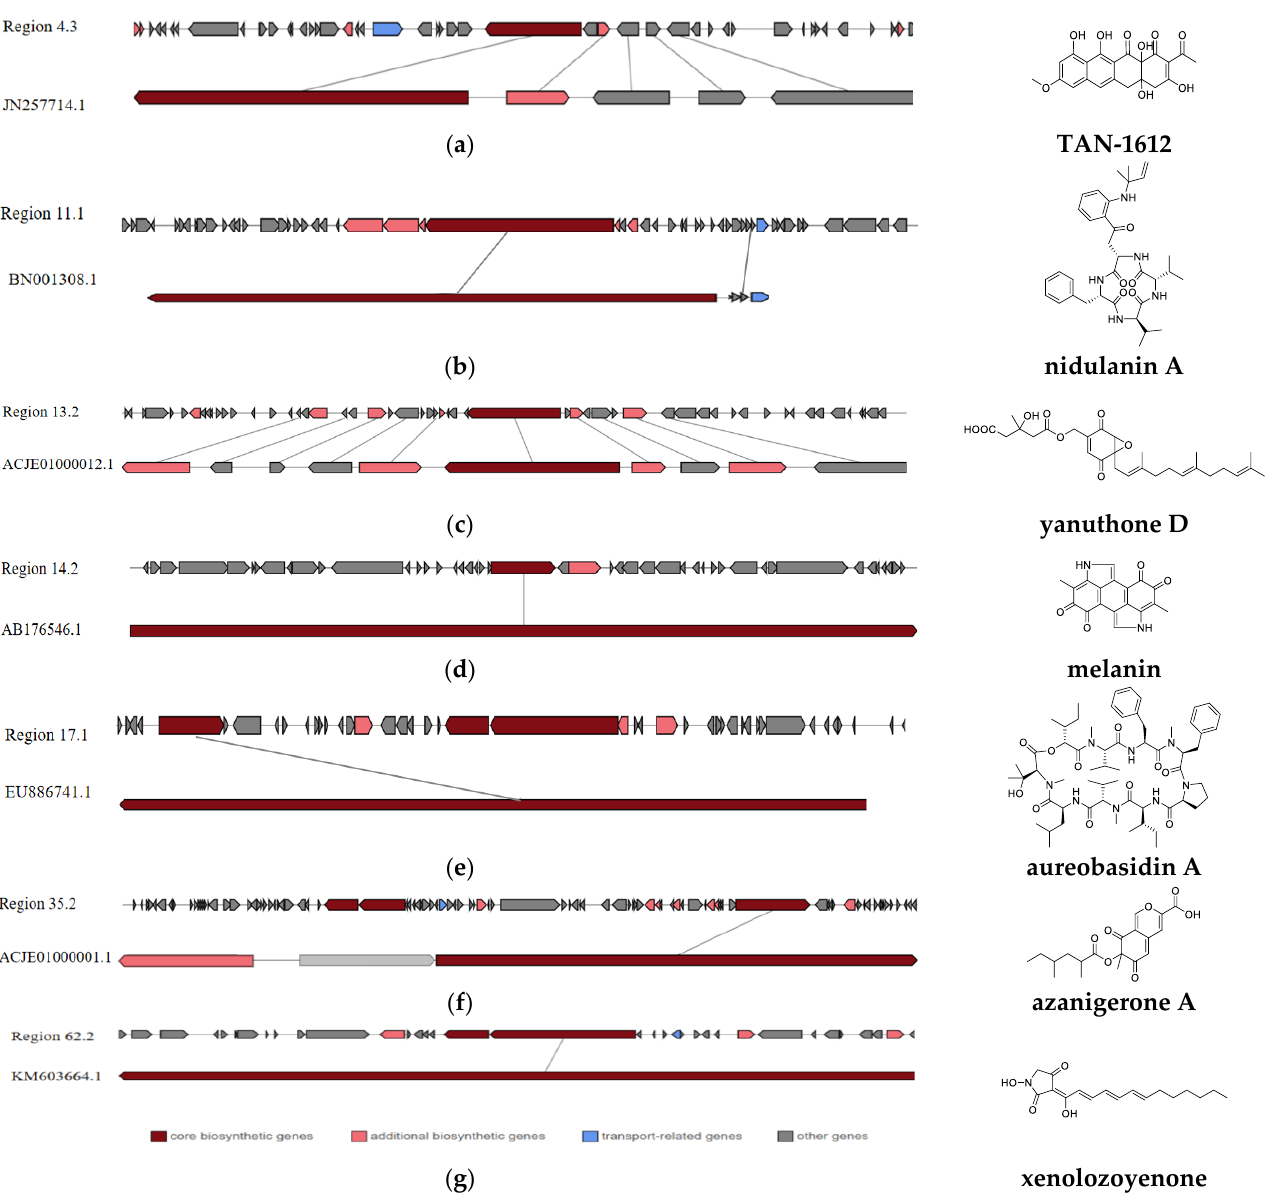
Figure 5. The number and types of secondary metabolite BGCs ( a ) and their putative products ( b ) in strain L14 and other A. niger strains deposited in antiSMASH database.